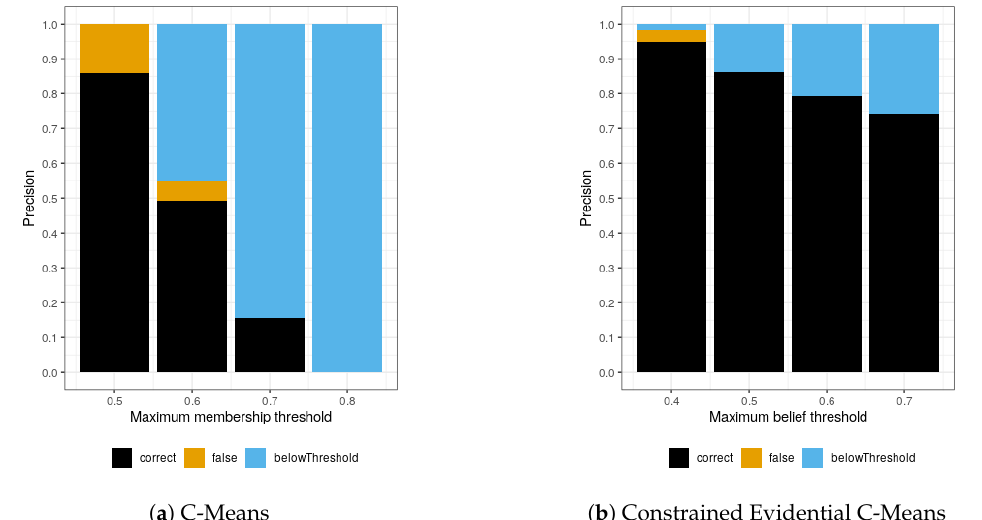
Figure 3. Results of living lab tracks clustering with C-Means and Constrained Evidential C-Means and filtering over cluster membership grades (C-Means) and normalized beliefs (CECM).